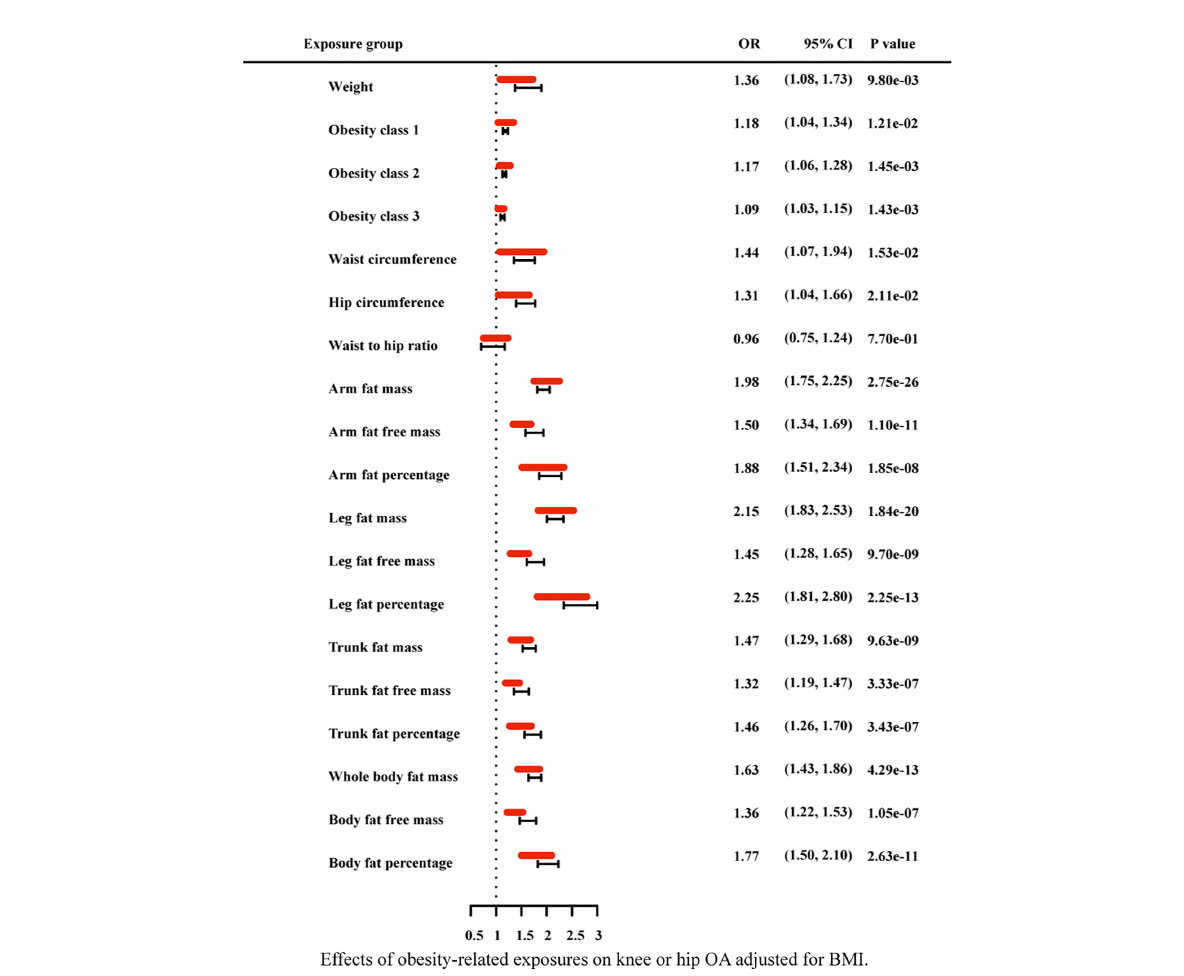
FIGURE 9 Effects of obesity-related exposures on knee or hip OA adjusted for BMI. Results from multivariable MR analyses showing the effects of genetic predicted obesity related anthropometric indicators and body compositions on knee or hip OA after adjusting for the effect of BMI, represented by red